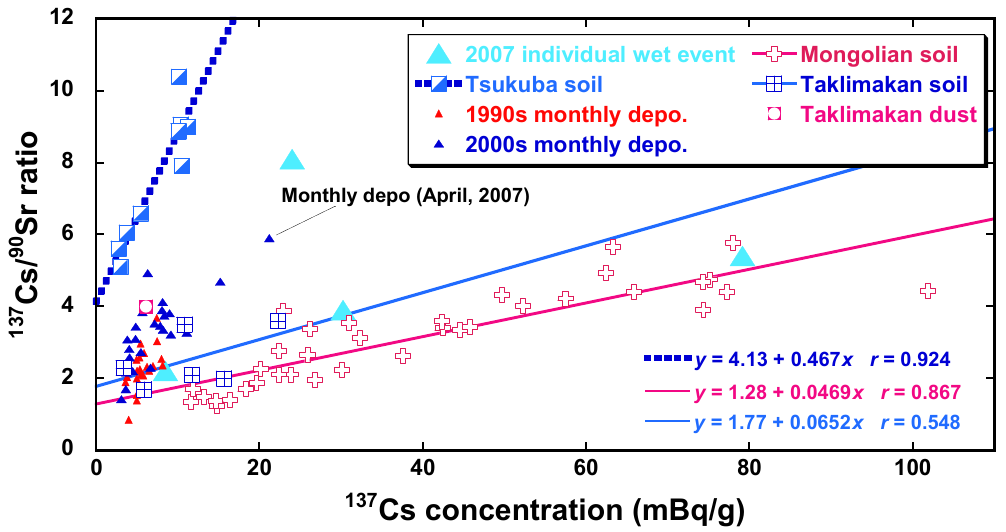
Fig. 4. A cross plot of Mongolian surface soil, Tsukuba surface soil, Taklimakan surface soil and dust, and atmospheric deposition (monthly and event samples) during spring (March, April, and May) in Tsukuba based on the relationship between 137 Cs specific activity (mBq g -1 ) and the 137 Cs/ 90 Sr activity ratio. The monthly deposition is total (wet + dry) deposition, and single wet depositions were collected during the spring of 2007 (from Igarashi et al., 2009). Taklimakan and Tsukuba soil data are based on Igarashi et al. (2005). Fitting curves are individually drawn for Mongolian, Tsukuba, and Taklimakan soils. All data are decay-corrected as of the time of sample collection in the fall of 2007.